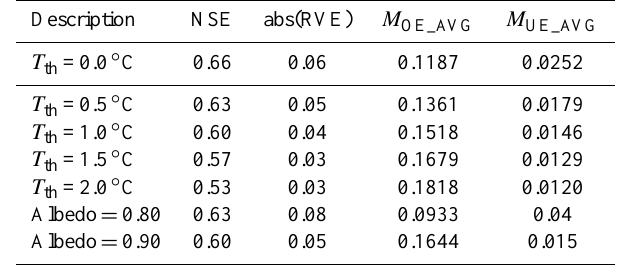
Table 7. Model sensitivity to uncertainty in model input, 2002– 2003. SW, Tair, WS and LAI are shortwave radiation, air temper- ature, wind speed and leaf area index respectively.